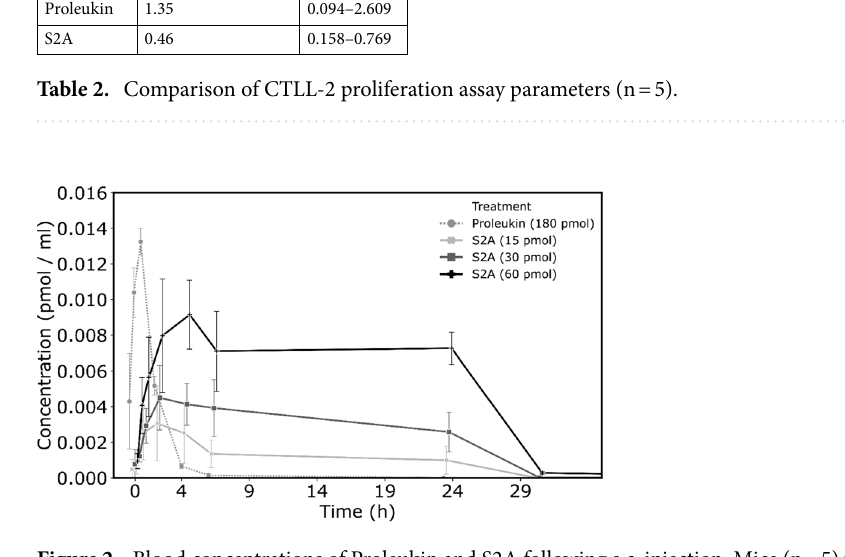
Figure 2. Blood concentrations of Proleukin and S2A following s.c. injection. Mice (n = 5) were injected subcutaneously with the indicated doses of Proleukin or S2A. Blood was then collected at 10 min, 30, min, 1 h, 2 h, 4 h, 24 h, 30 h, 42 h and 72 h. Levels of Proleukin or S2A were measured by ELISA. Bars represent SD.